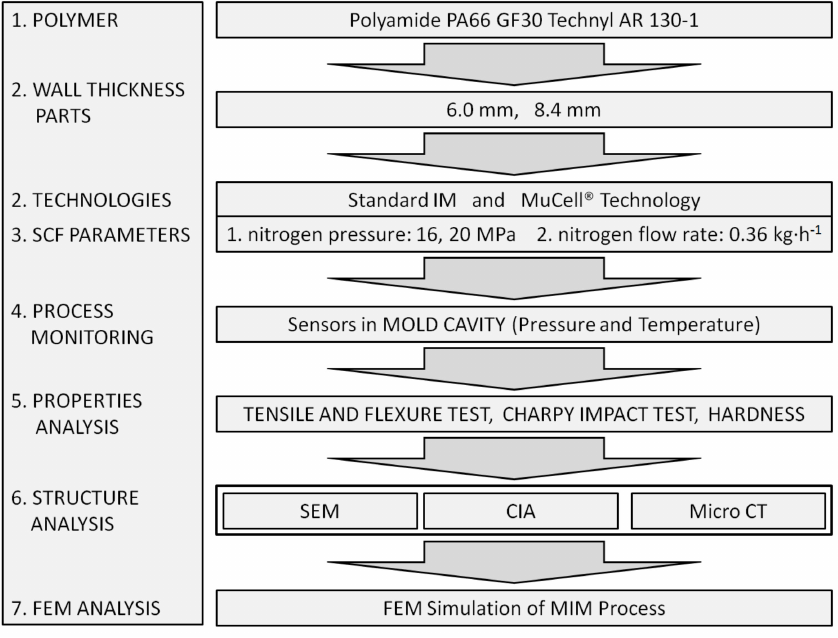
Figure 1. Experiment flow diagram with input and output